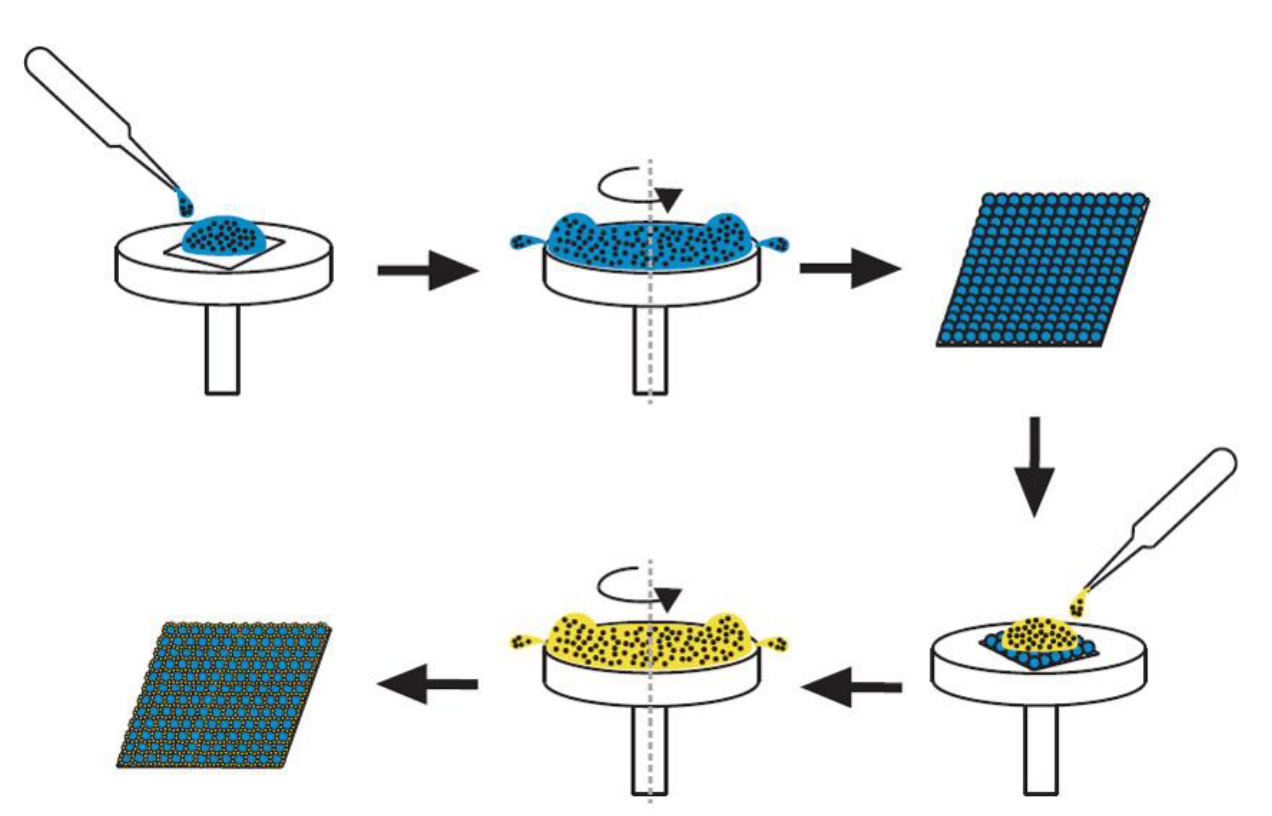
Figure 1. The schematic experimental process for assembly of binary nanosphere arrays. Table 1. The operation conditions utilized for spin coating of binary 900 nm/300 nm nanosphere arrays.